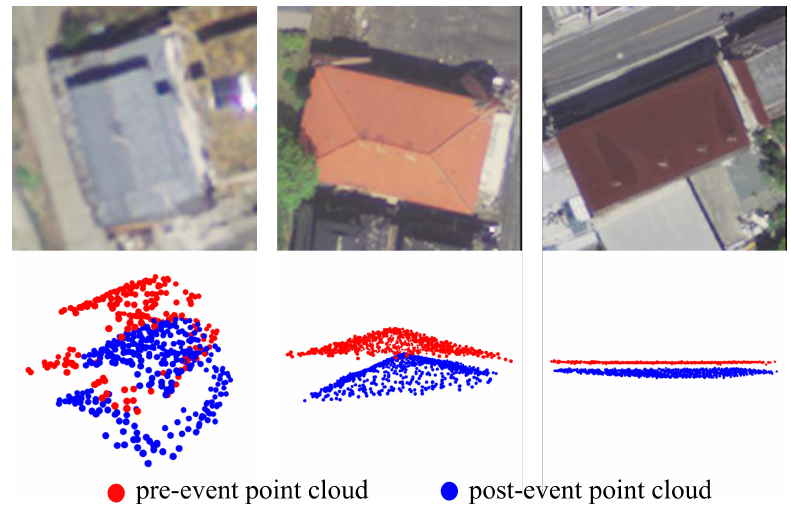
Figure 1. Examples of collapsed buildings that are hard to detect in vertical images. Aerial images were provided by